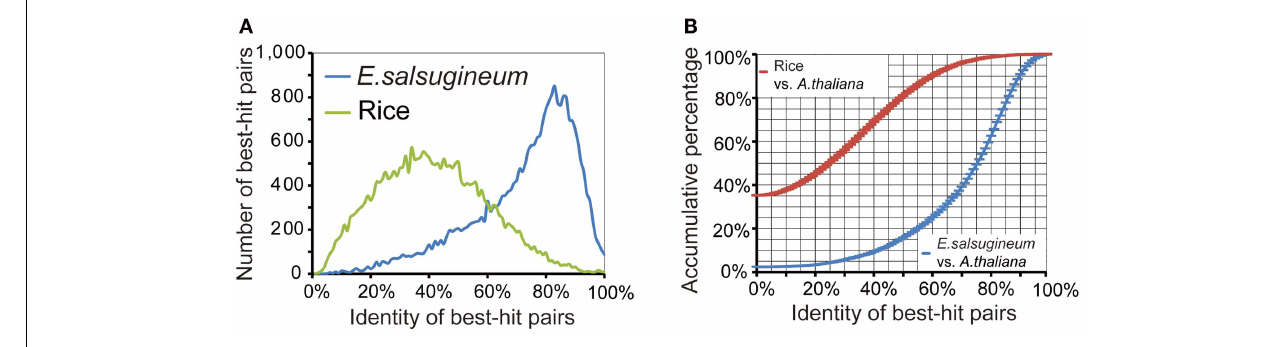
FIGURE 2 | Determination of homology cutoff. (A) Protein-level homology distributions of E. salsugineum and rice genes against A. thaliana genes. (B) Cumulative percentage of orthologs in E. salsugineum and rice compared to A. thaliana .